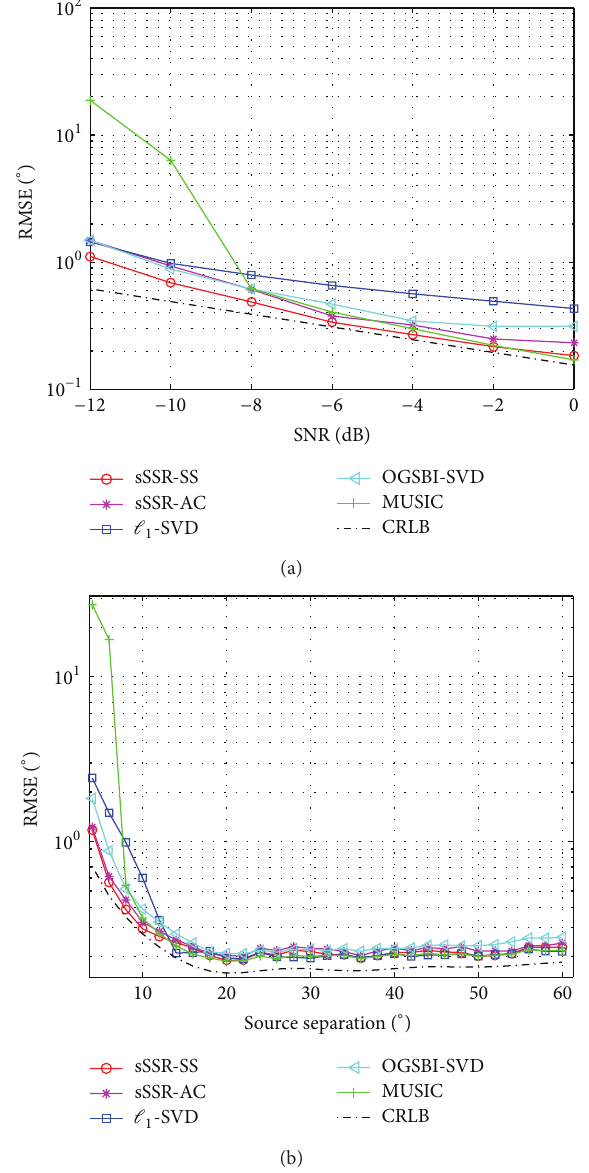
Figure 5: RMSE of ℓ 1 -SVD, OGSBI-SVD, MUSIC, sSSR-AC, and sSSR-SS with respect to (a) SNR with source separation 10 ∘ fixed and (b) source separation with SNR = 0 dB fixed.